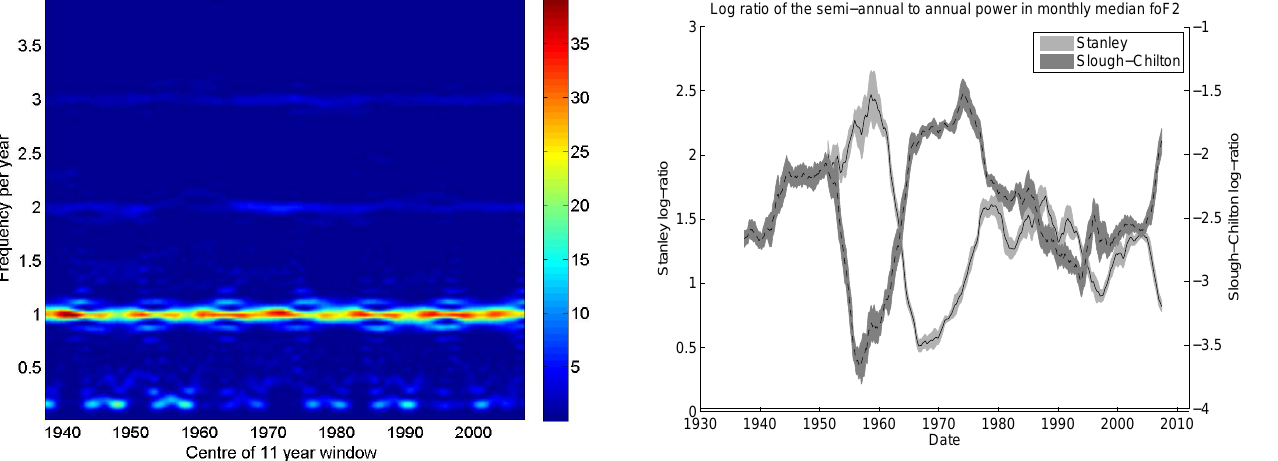
Fig. 2. Lomb–Scargle periodogram for the local noon ionospheric F2 layer above Slough/Chilton. The relative power between fre- quencies is displayed in the colour axis showing a dominant annual variation (frequency per year of 1) .